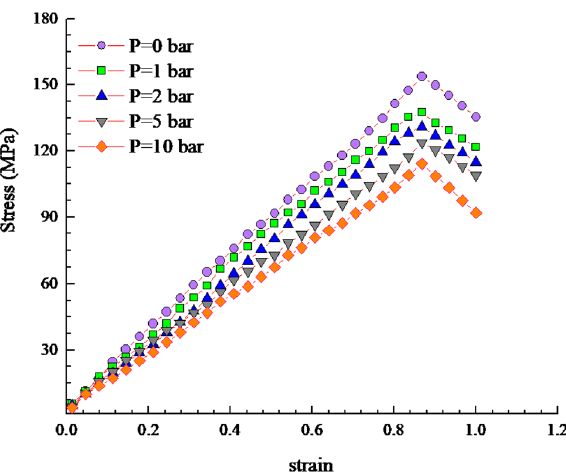
Figure 7. BAG’s stress–strain curve functions initial pressure in the MD simulation box.